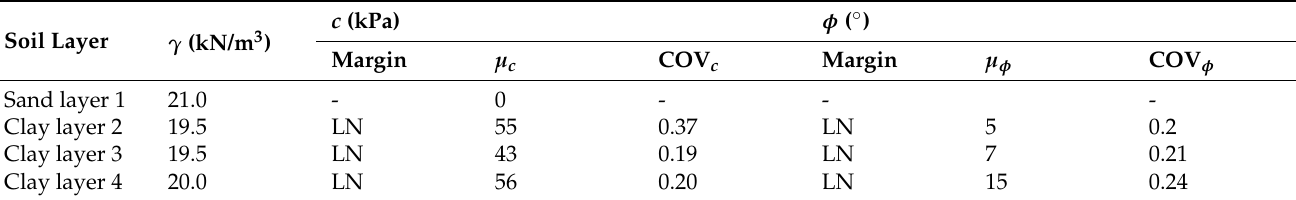
Table 6. Statistics of soil parameters of the Chicago Congress Street cut slope.